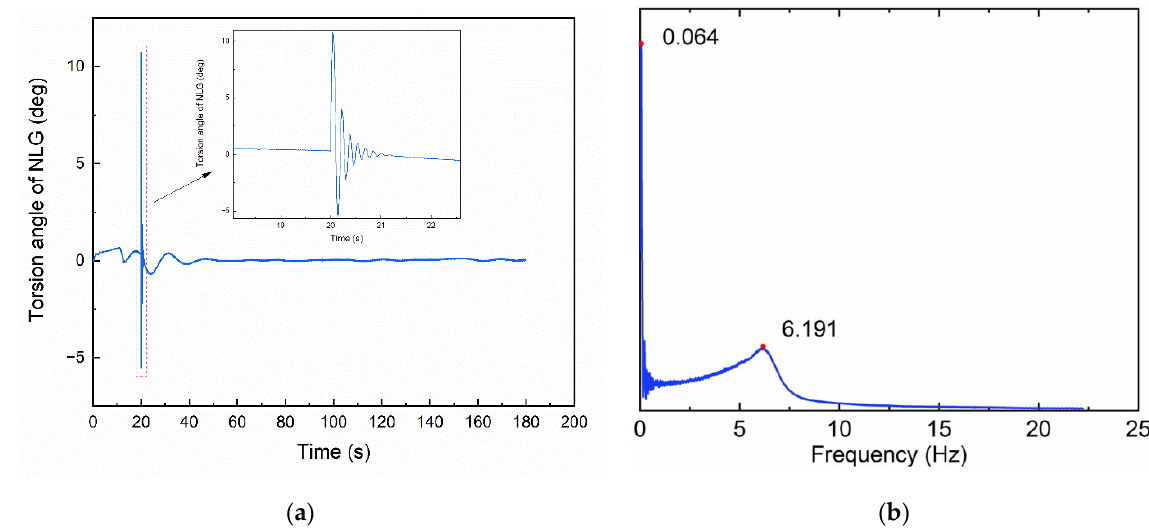
Figure 13. Relationship between NLG shimmy and aircraft directional stability with torsional damping of 100 N m s/rad. ( a ) Torsion angle of NLG; ( b ) Frequency of vibration.